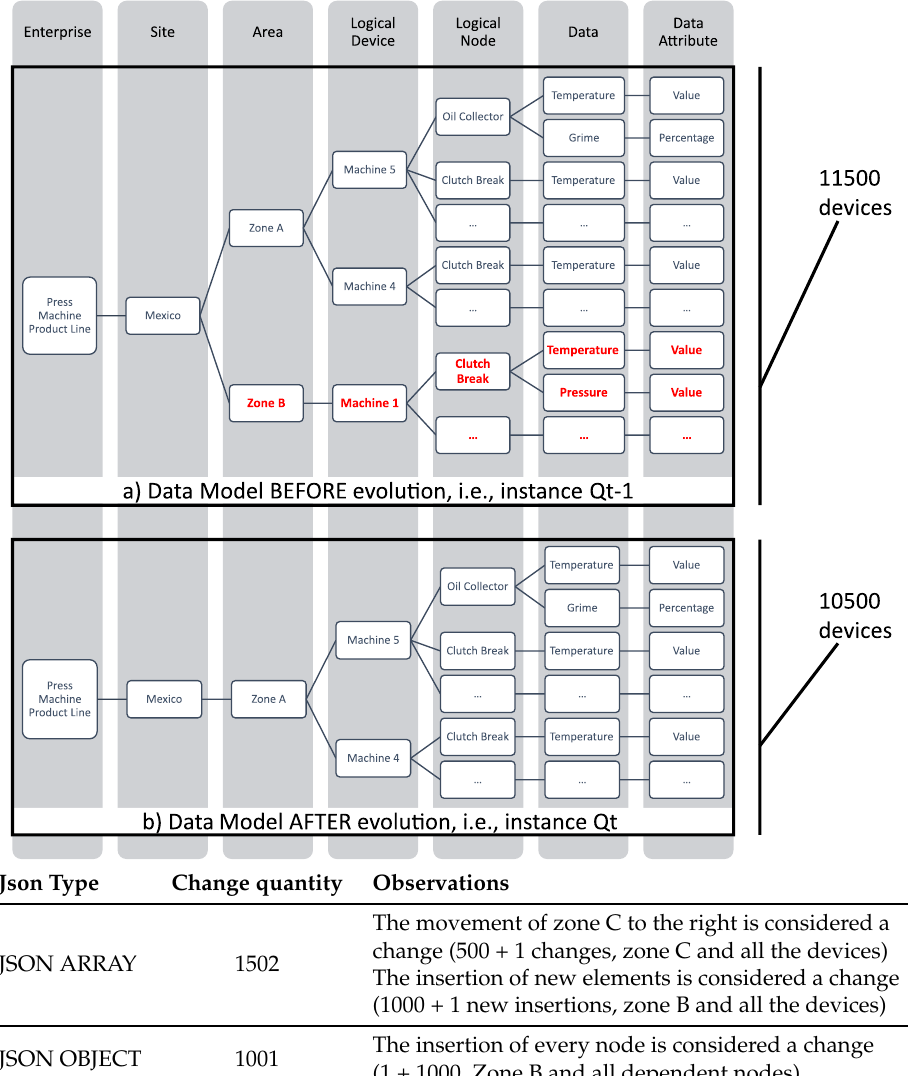
Figure 3. Text model comparator operations depending on the